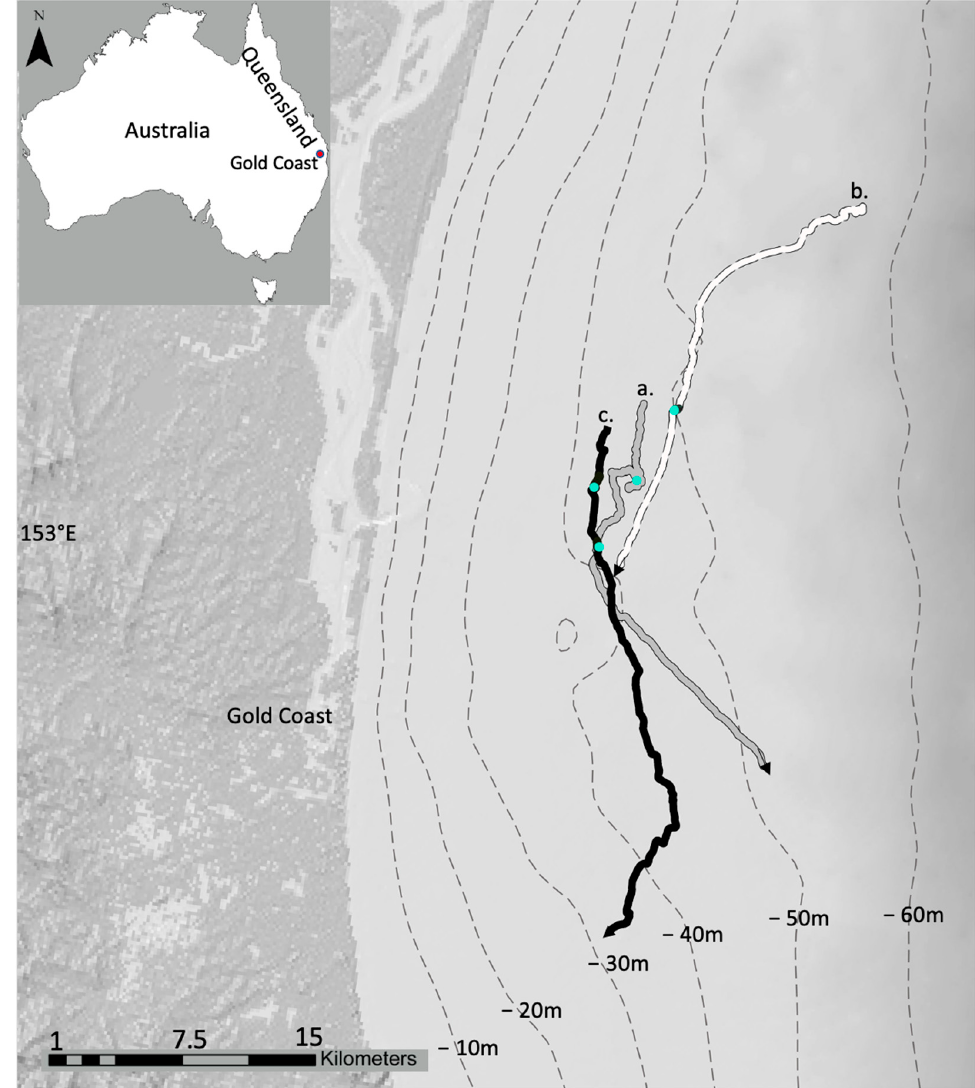
Figure 1. Map of study area on the Gold Coast, Australia, and three tracks (tag a: 31 August 2021; tag b: 6 October 2021; tag c: 26 September 2022) with arrows indicating a predominantly southern direction of movement for all three deployments. The locations of sand rolling are shown by dots on top of the tracks. Bathymetry contour lines in 10 m depth intervals.